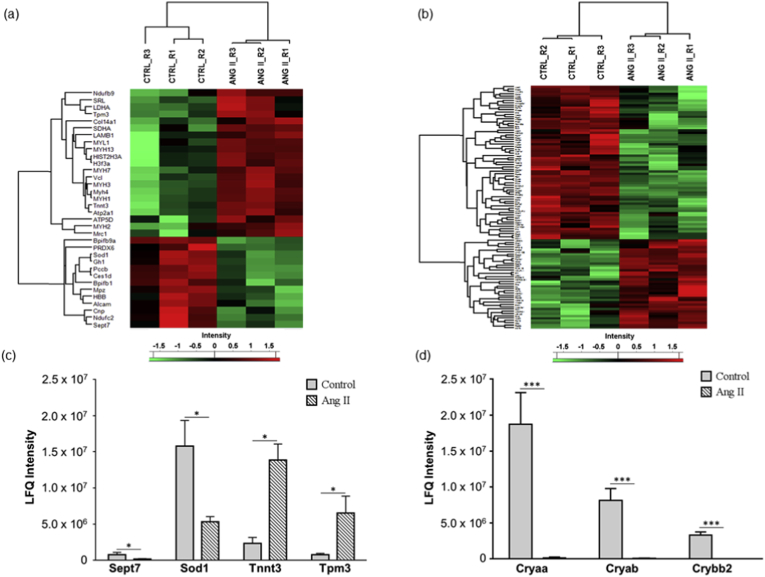
Differential expression profiles of ophthalmic arterial and retinal proteins. The hierarchical clustering of the differentially expressed proteins represented in a heat map for (a) ophthalmic artery and (b) retina. The upregulated proteins are shown in red and the downregulated proteins are in green. R1-R3: Biological replicate 1 to 3. Bar charts showing the expression profiles of highly significant exemplary proteins in the Ang II group compared to control in the (c) ophthalmic artery and (d) retina. The expressions of Sept7 and Sod1 were significantly decreased, while Tnnt3 and Tpm3 were increased in the ophthalmic artery. All three crystallin proteins were significantly decreased or absent in the retinal samples subjected to Ang II. *p < 0.05; ***p < 0.001. (For interpretation of the references to colour in this figure legend, the reader is referred to the Web version of this article.)